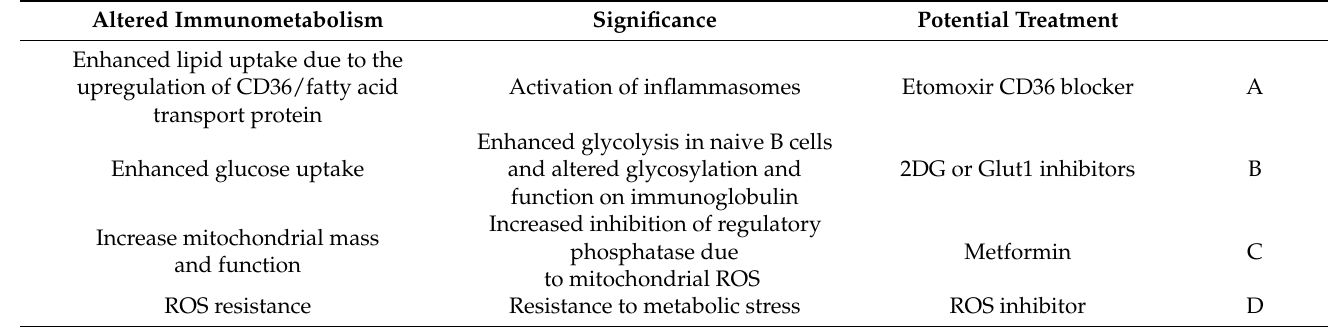
Table 1. Altered immunometabolism, significance, and potential treatment for glycolysis, FAO, and OXPHOS. This Table was adapted from the article by Wilson, C.S. and Moore, D.J.